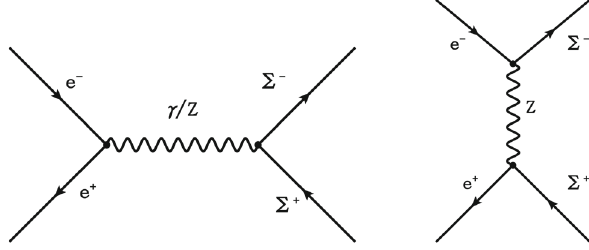
Fig. 3 Feynmandiagramscontributingtotheprocess e + e − → (cid:2) + (cid:2)